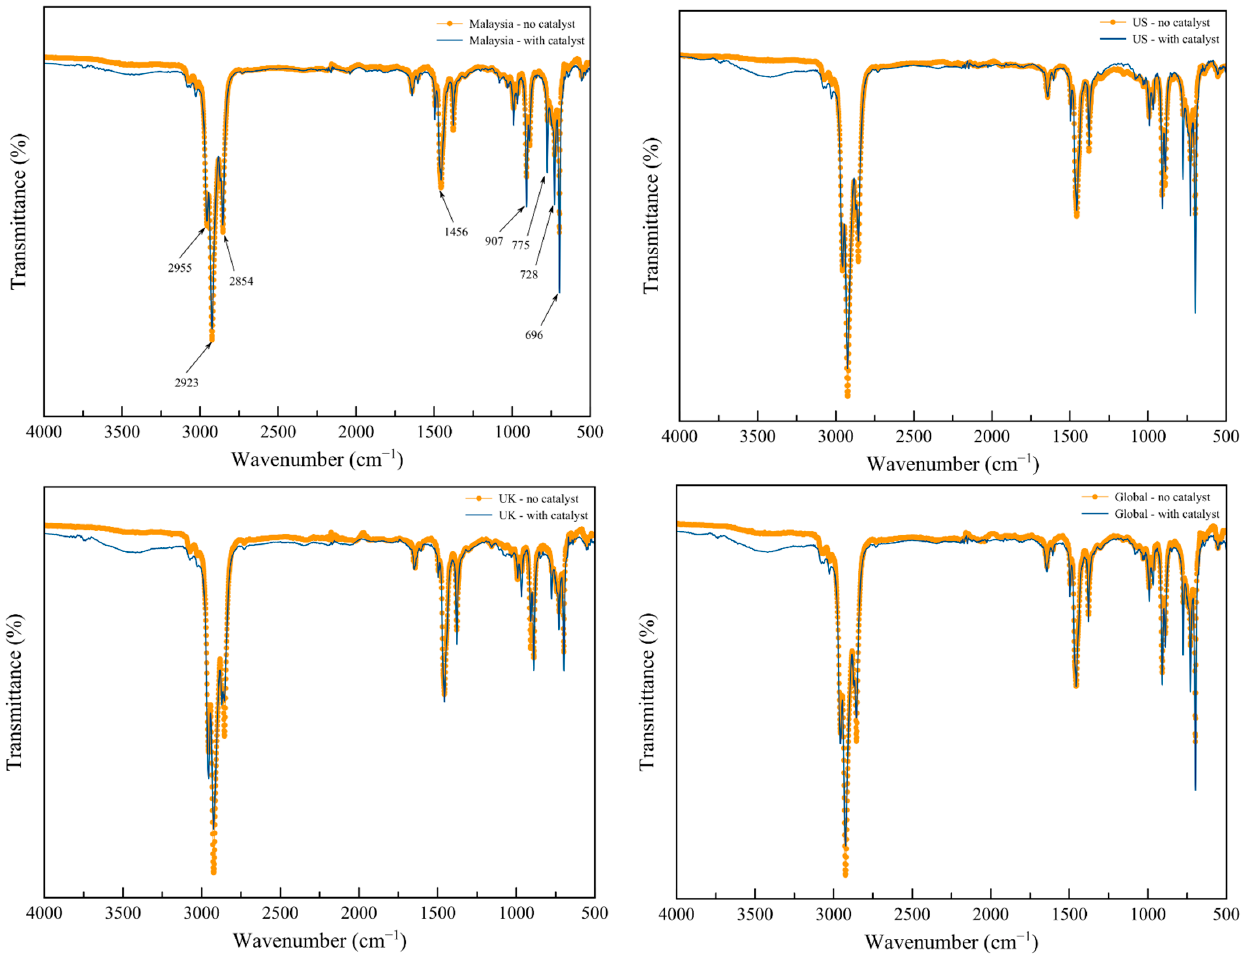
Figure 6. FTIR spectra of pyrolysis oil from thermal pyrolysis and catalytic pyrolysis of mixed plastic.